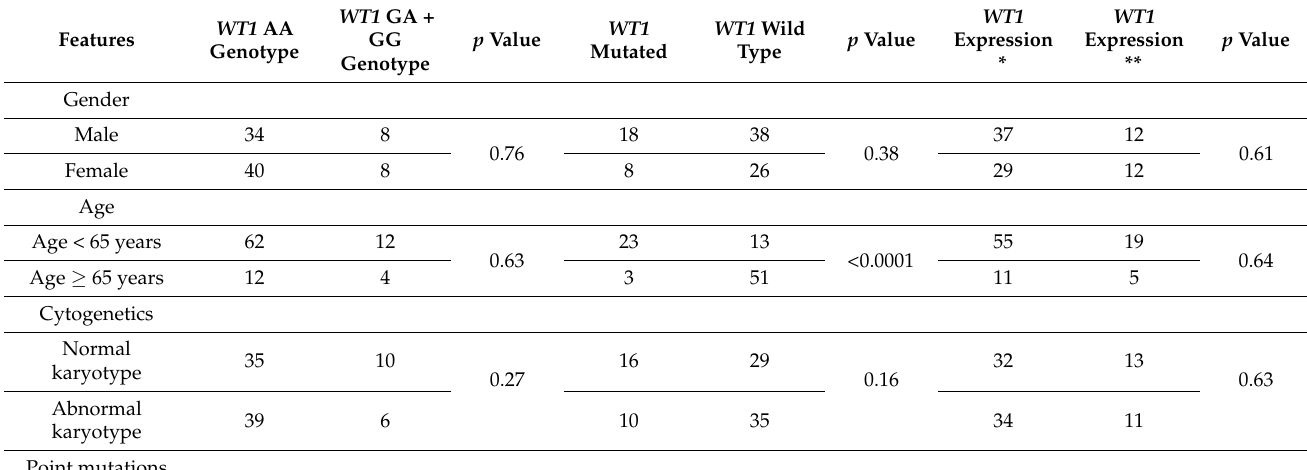
Table 4. Correlation of WT1 variants and overexpression with clinical characteristics in AML